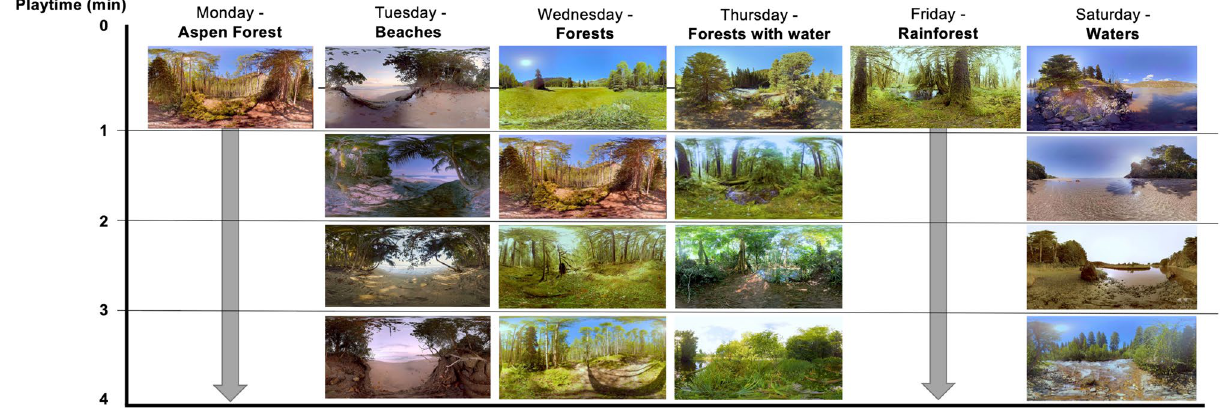
Figure 3. 360-degree videos shown in the virtual nature intervention (Courtesy of